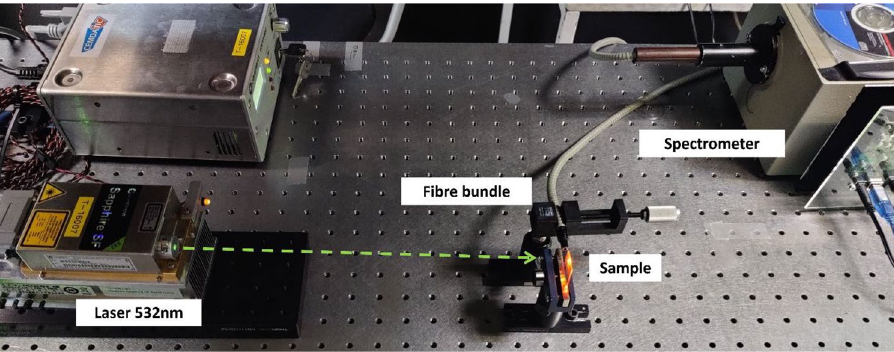
Figure 1. Photograph of setup used for fluorescence characterization of dye doped photoresists. A 532 nm laser impinges perpendicularly to the sample, and the fluorescence is measured edge on using a fiber bundle and a spectrophotometer